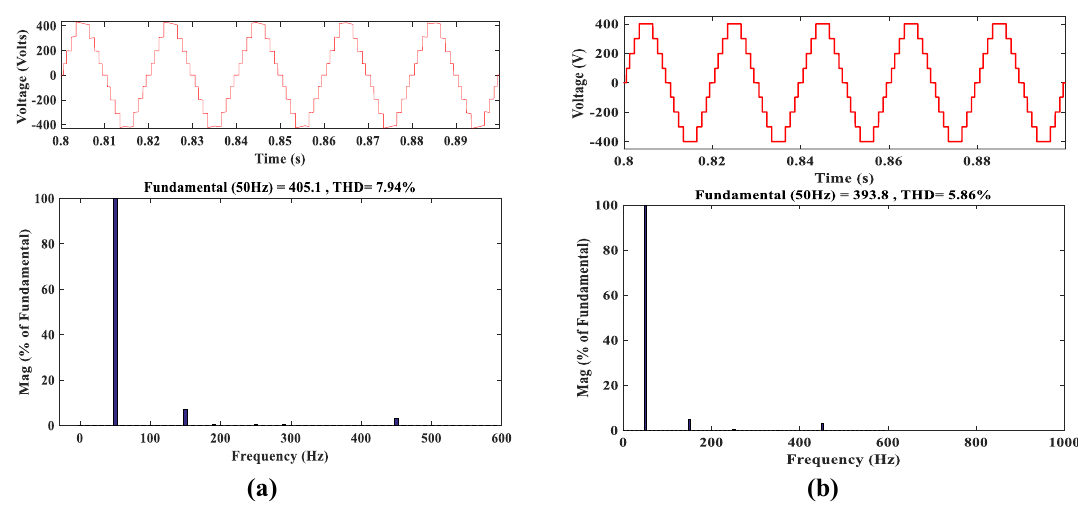
Fig.7 Percentage THD of nine-level proposed converter a with MPPT algorithm b with DC voltage source of 100